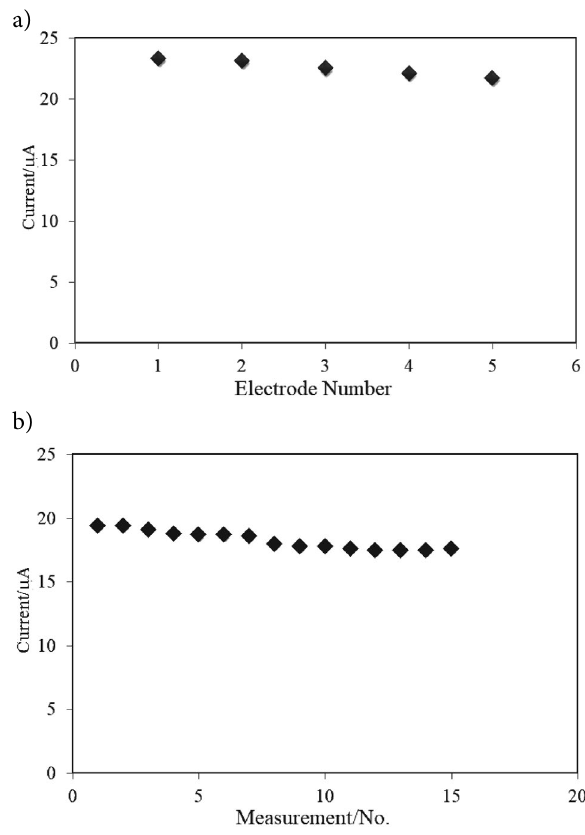
Figure 11. Current response towards 10 mM glucose in 0.1 M NaOH (a) with five identical Au/PANI/Pt sensors (b) for 15 succes- sive measurements with Au/PANI/Pt